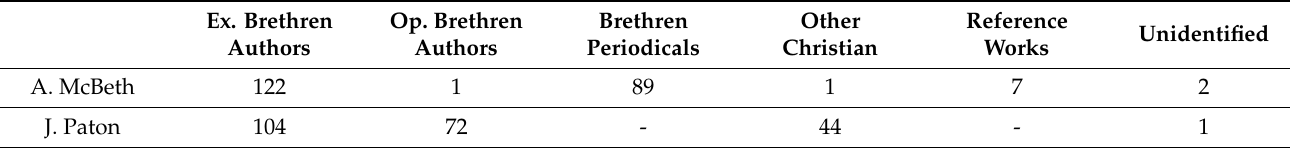
Table 3. Alexander McBeth’s library, 1930, and Jas. Paton’s library, c